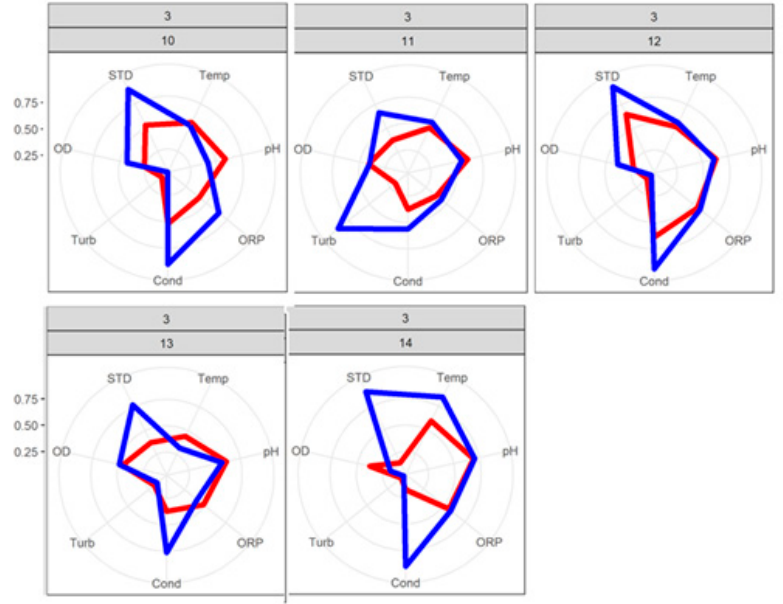
Figure 9. Correlation of water quality parameters during wet and dry seasons in the hydrological compartment (HC) 3. Red line (dry season) and blue line (wet season).